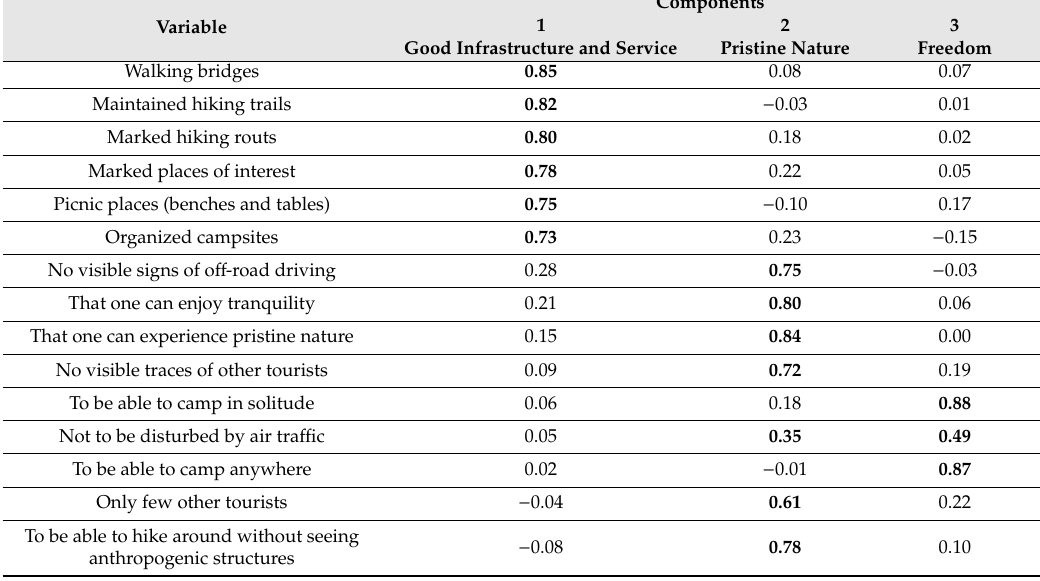
Table 3. Principal component analysis of important elements in wilderness.